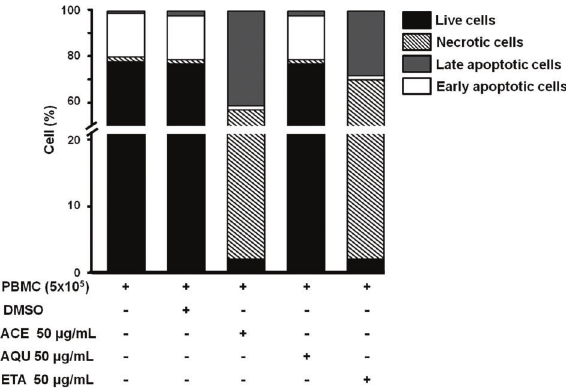
Figure 1. Analysis of the cytotoxic effect of P. brasiliensis aqueous extract with the trypan blue exclusion assay. Percentage of viable cells in cultures of peripheral blood mononuclear cells (PBMCs) treated with or without P. brasiliensis aqueous extract (AQU) after 24 h ( A ) or 5 days ( B ) of incubation. Evaluation was done with trypan blue exclusion assay (n=8). Culture treated with cadmium chloride (CdCl 2 ) constituted the positive control of cell death. Results are reported as means ± SD. Different letters indicate signi fi cant differences (P p 0.05, ANOVA with Tukey post hoc ).